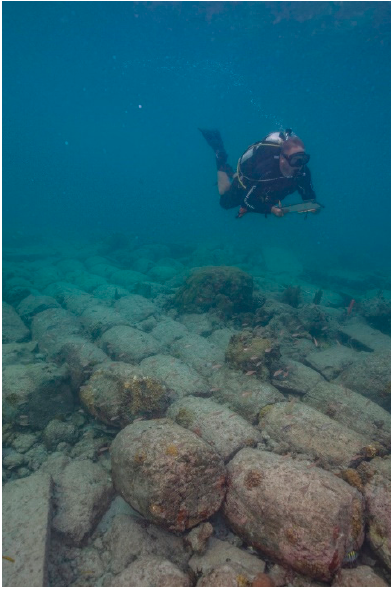
Figure 2. An National Park Service (NPS) archaeologist swims over cement barrels on the East Key Construction Wreck.